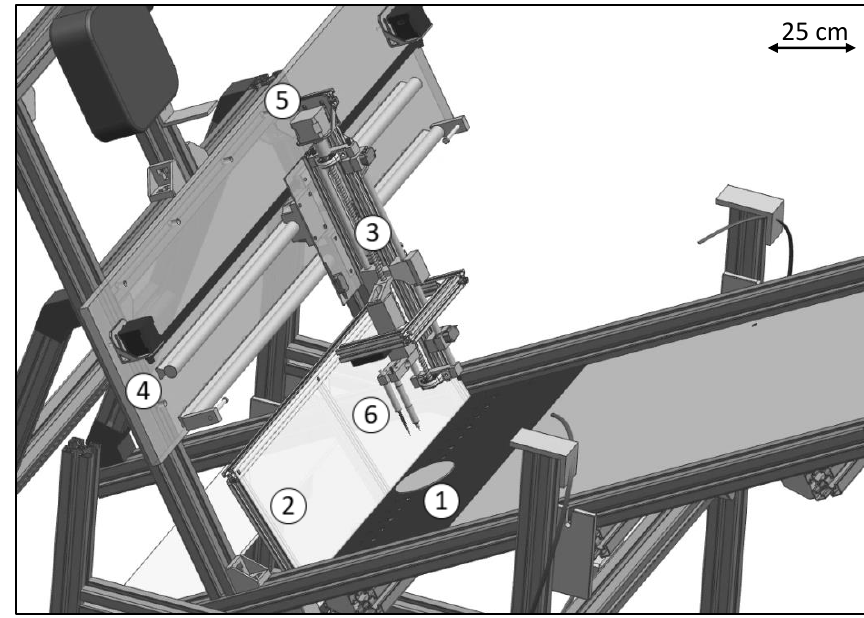
Figure 2. Tactile sensor for measuring mechanical properties of paper